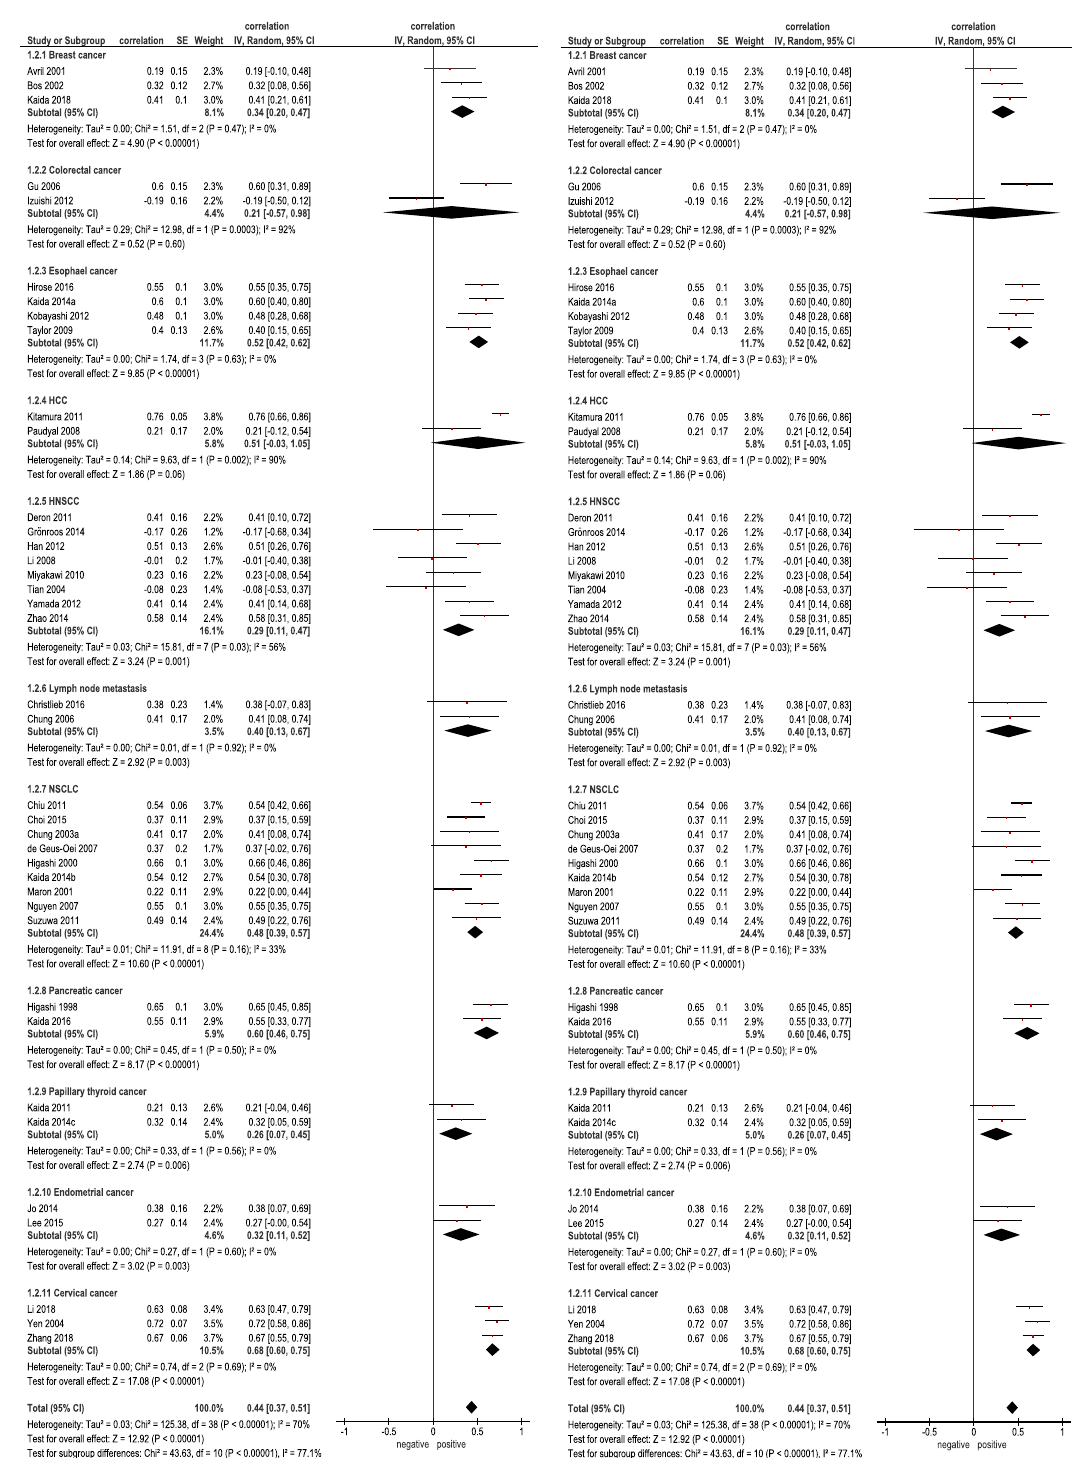
Fig 4. Subgroup analyses for the correlation between SUVmax and GLUT 1 expression. Forrest plots of the correlation coefficients between SUVmax and GLUT 1 in different primary tumors.